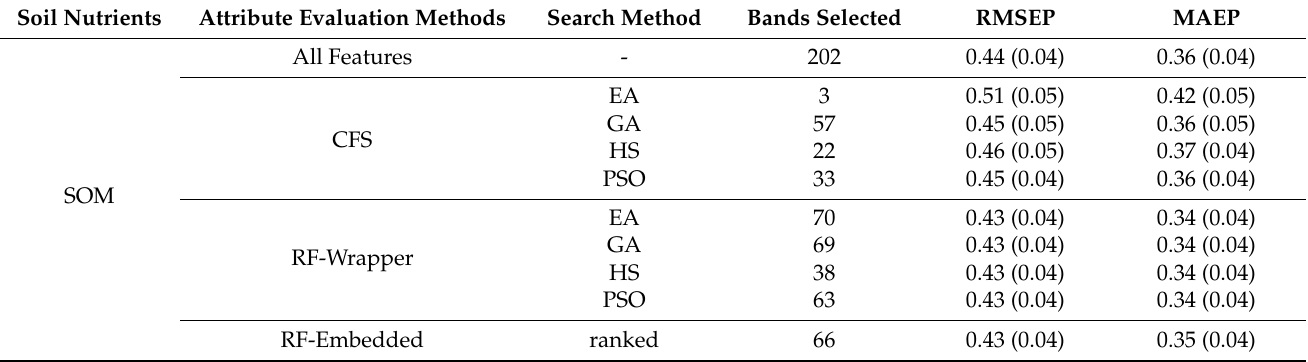
Table 6. Mean and standard deviations of goodness-of-fit statistics values calculated from the RF